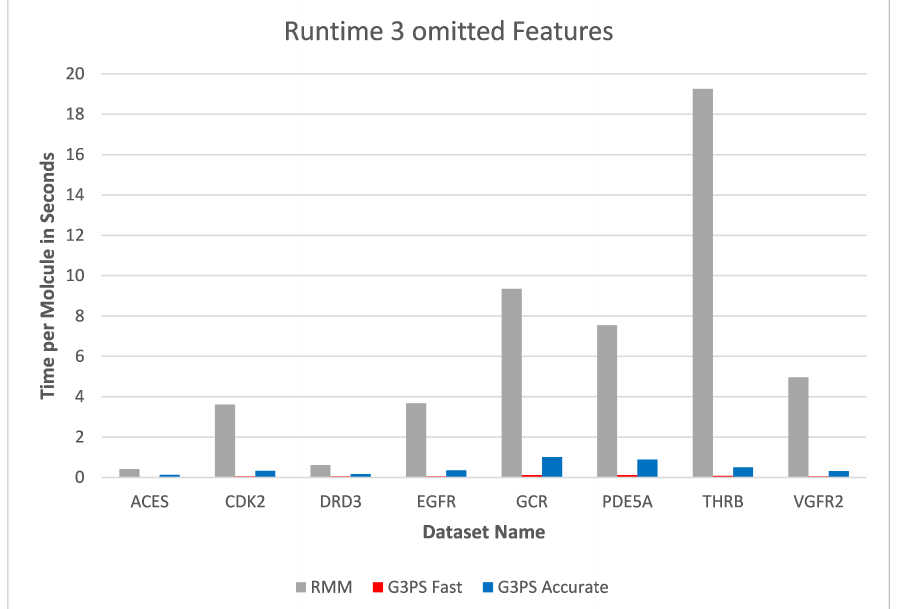
Figure 16. Screening benchmark runtimes with three omitted features.